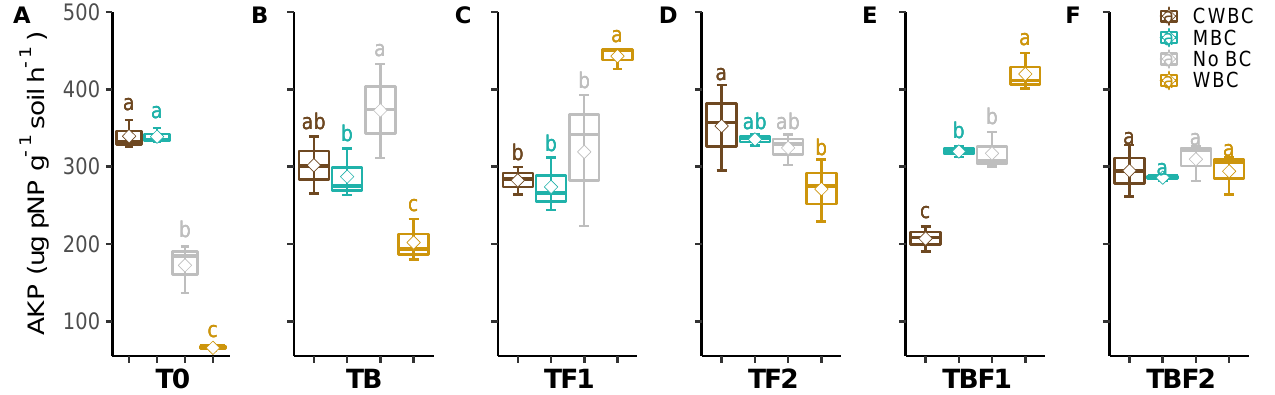
Figure 4. Effect of microbial inoculants on soil alkaline phosphomonoesterase activity after biochar application. Treatment abbreviations—see Figure 1. Quantiles are shown at the top and bottom of the box. Max and min values are indicated by the bars. The lines within the box indicate the median values. The transparent dot indicates the observation value. Letters above the bars indicate the significance level at p < 0.05 by